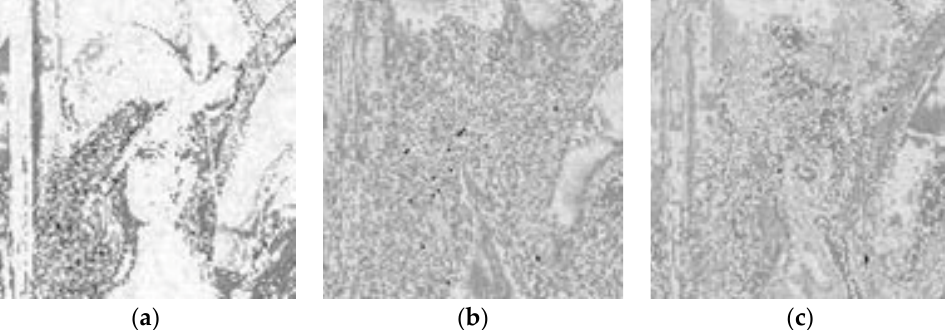
Figure 3. RGB ‐ channel image after the replacement of Lena pixel value: ( a ) replacement, after R ‐ channel image; ( b ) replacement, G ‐ channel image; ( c ) replacement, B ‐ channel image.